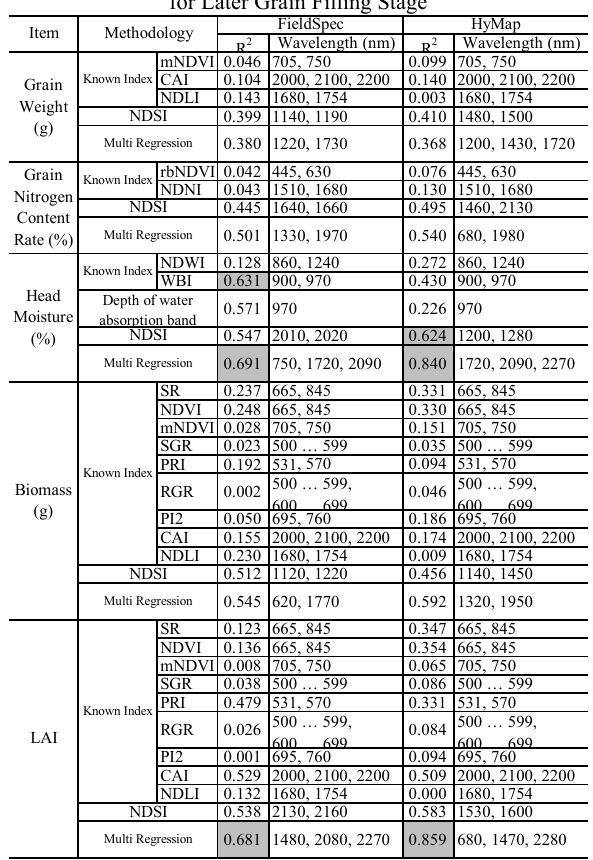
Table 4: Determination Coefficient